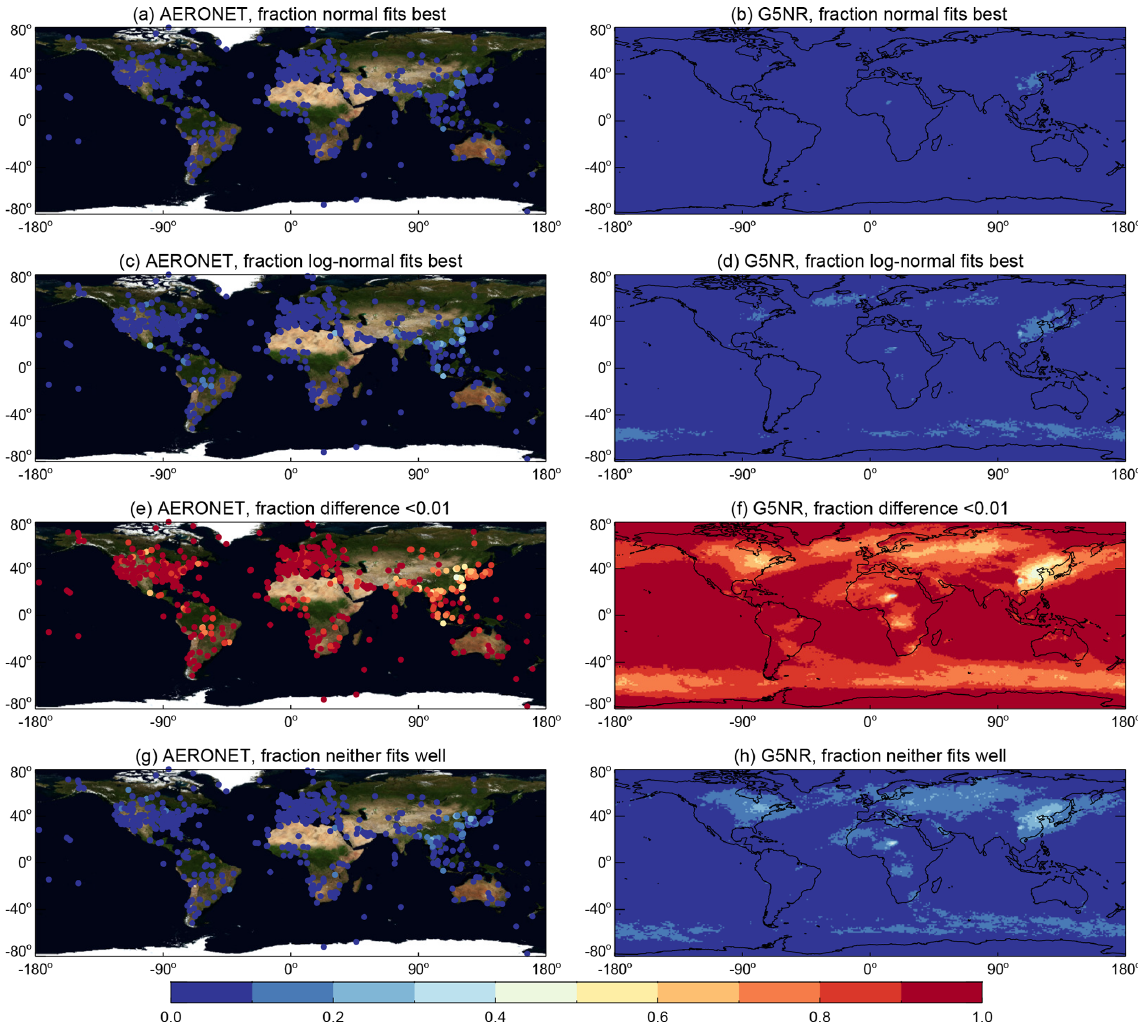
Figure 3. Fraction of data falling into each of the four categories of Shapiro–Wilk test results for AOD distributions aggregated temporally over a day. Columns show (left) AERONET and (right) G5NR data (note that the latter were previously spatially aggregated to 1 ◦ ). From top to bottom, rows indicate the fraction where the data are more consistent with a normal distribution and |¯ τ l − ¯ τ n | > 0 . 01, fraction more consistent with a log-normal distribution and |¯ τ l − ¯ τ n | > 0 . 01, fraction where |¯ τ l − ¯ τ n | ≤ 0 . 01, and fraction where |¯ τ l − ¯ τ n | > 0 . 01, and the data show large discrepancies from frequencies expected by both normal and log-normal distributions. For AERONET, at least 50d are required for a site to be considered